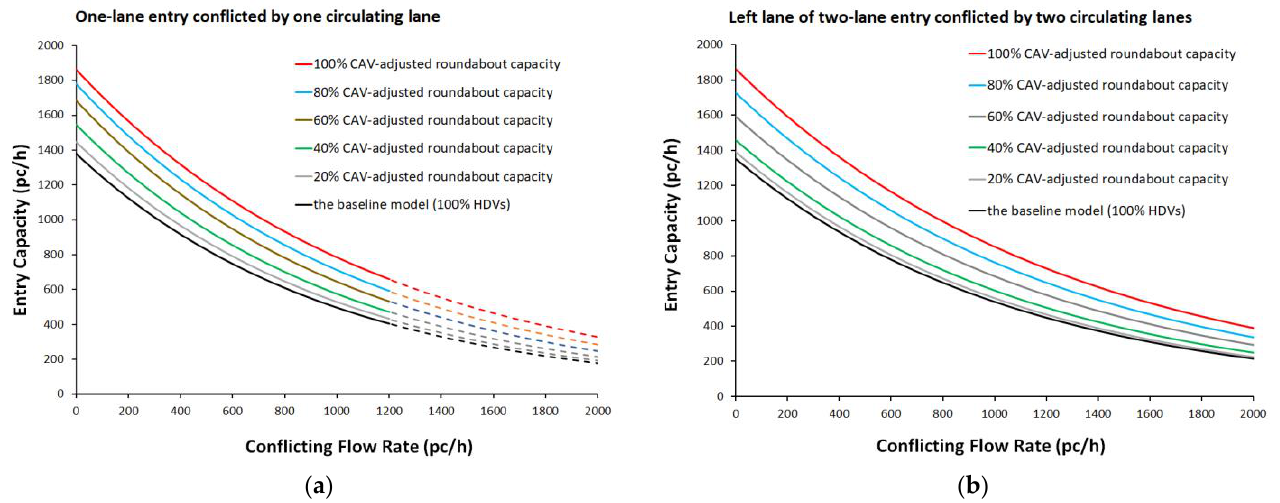
Figure 2. The baseline model for 100% HDVs and the CAV-adjusted roundabout capacity curves under different penetration rates of CAVs for: ( a ) the one-lane entry conflicted by one circulating lane (where dashed regression is extrapolated beyond the data); ( b ) the left entry lane of a two-lane entry conflicted by two circulating lanes (where the operational range depends on the geometry under study). Source: Own research based on data presented in [2].